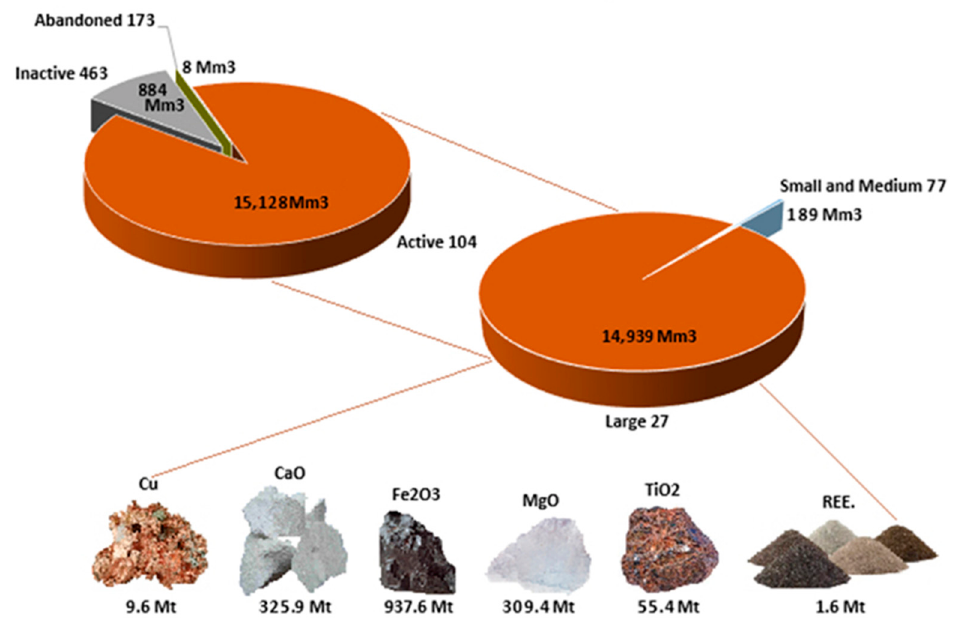
Figure 4. Valuable species tonnage that can be recovered from the largest tailing deposits in Chile generated around 318 Mt of tailings in 2012, about 511 Mt in 2016, and, by 2020, is expected to generate around 600 Mt [61]. Of the 27 active tailings deposits, 37.1% (wt.%) of the total tonnage are located in the Antofagasta region in six large-scale active deposits. The deposit of Laguna Seca has the largest sequestration potential of 44.09 Mt of CO 2 due to its large tonnage, whereas the Esperanza deposit can sequester the greatest amount of